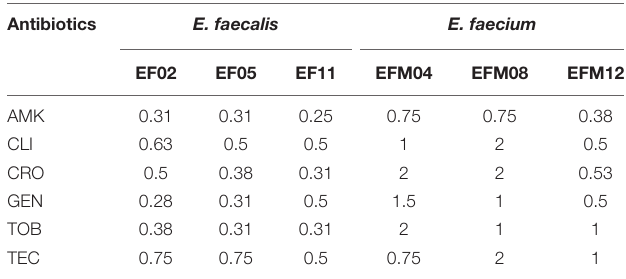
TABLE 3 | The optimal FIC between BT and antibiotics against E. faecalis and E. faecium . Antibiotics E. faecalis